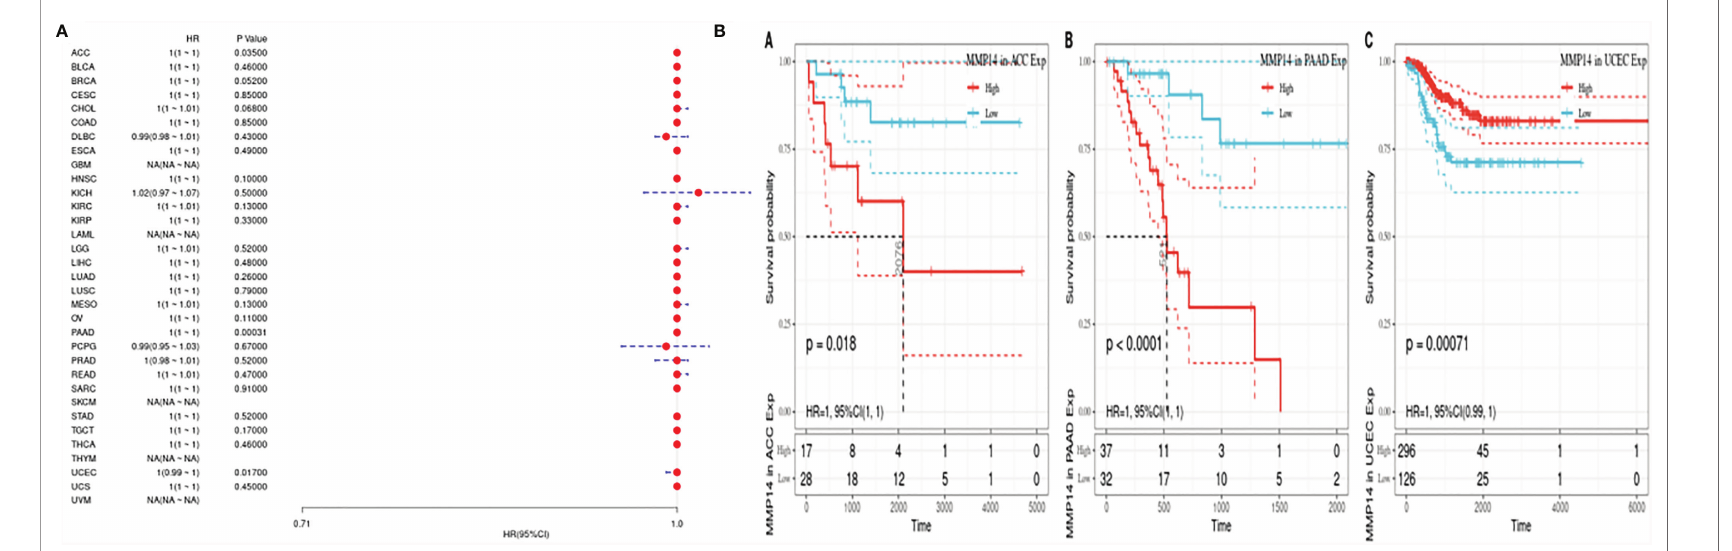
FIGURE 3 | The expression of matrix metalloproteinase 14 (MMP14) was correlated with disease-free survival (DFS), and prognosis was analyzed by disease-free interval (DFI). The expression of MMP14 and the overall survival rate of pan-cancer were analyzed by DFI. (A) Correlation analysis of MMP14 expression and DFI in different cancer types of The Cancer Genome Atlas (TCGA). The red part represents the risk ratio. Due to the limited sample size, the parameters and hazard ratio could not be calculated with short bars, and the red font indicates p < 0.05. (B) Kaplan – Meier analysis was used to generate a survival curve for the prognostic effect of MMP14 expression on pan-cancer. DFI, disease-free interval